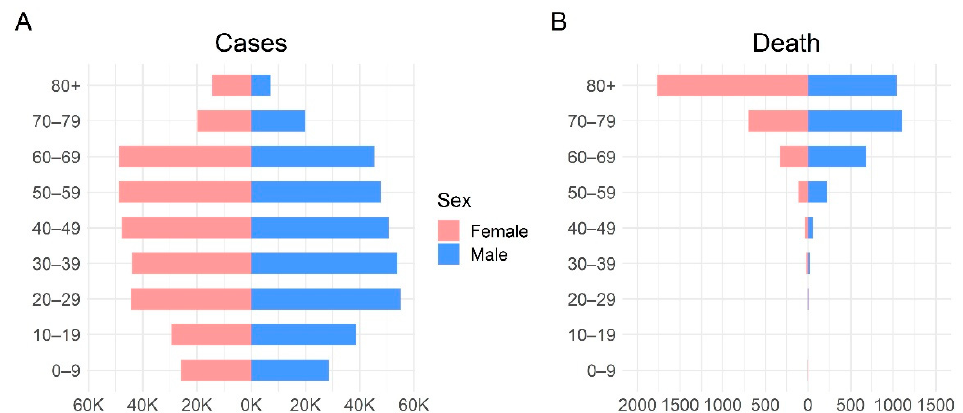
Figure 1. Demographics of patients with COVID-19 in the Republic of Korea. ( A ), number of confirmed COVID-19 cases; ( B ), number of confirmed COVID-19 deaths. COVID-19, coronavirus disease. Number of samples ( N samples ) is reported for the whole